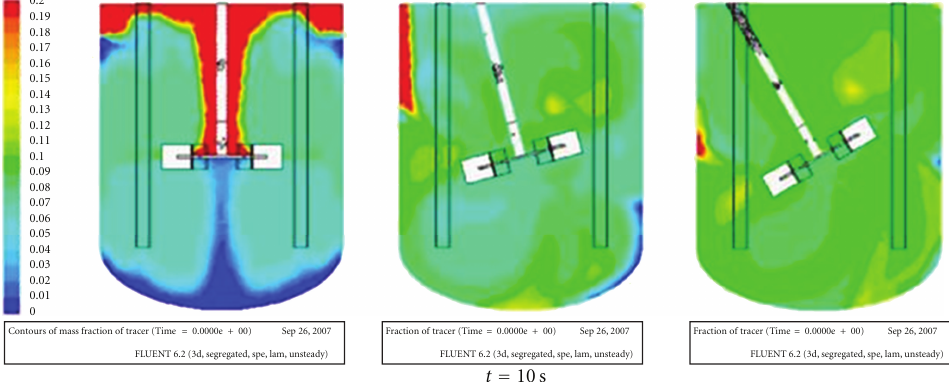
Figure 10: Simulation result of mixing of two miscible